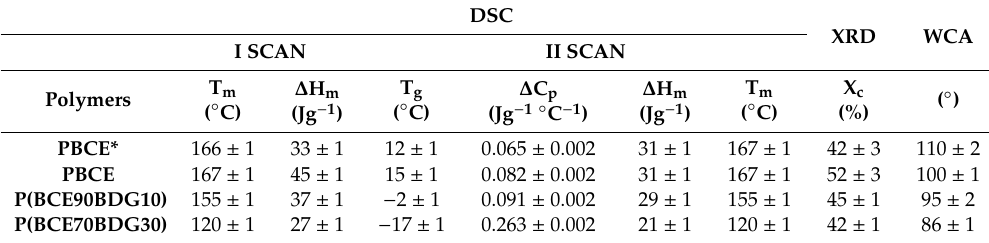
Table 1. Thermal, and wettability properties of the PBCE-based films. Thermal, X-Ray Di ff raction (XRD) and Wettability properties of PBCE*, PBCE, BDG10 and BDG30 polymer films. Thermal